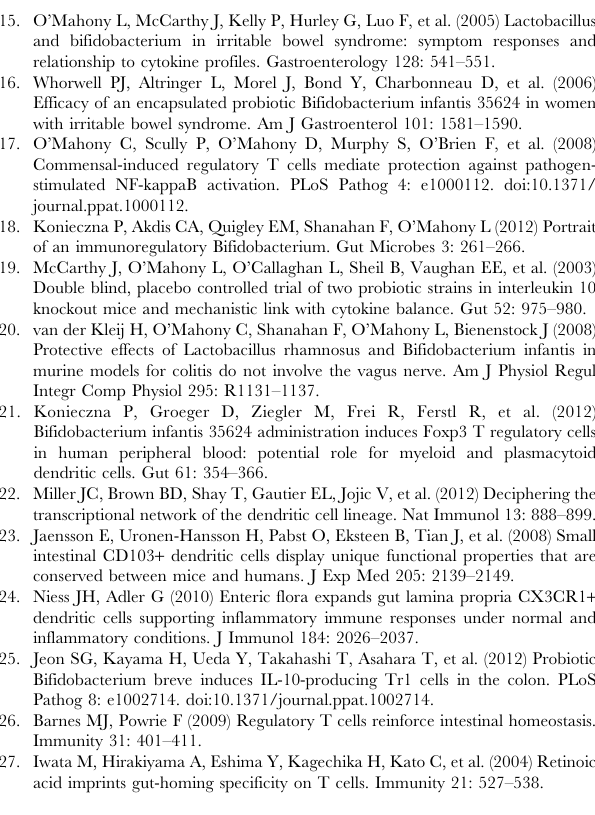
Figure S1 B. infantis is bound at a low frequency by CD11c + MHCII + CD103 2 dendritic cells. Flow cytometric analysis of CD11c + MHCII + CD103 2 dendritic cells from the mucosa demonstrated that approximately 10% of CD103 2 dendritic cells bound B. infantis